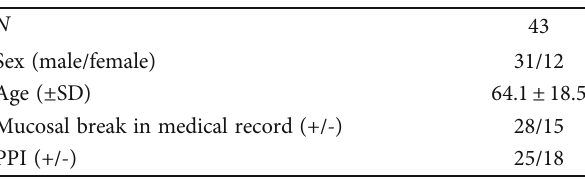
Figure 3: Example image fi le of magni fi ed narrow-band imaging used in this study (same patient as Figures 1 and 2). The areas of sharply demarcated erythema noted on white-light images were completely epithelialized (blue arrows), and all 8 endoscopists judged the images not to show a mucosal break. Table 1: Patient